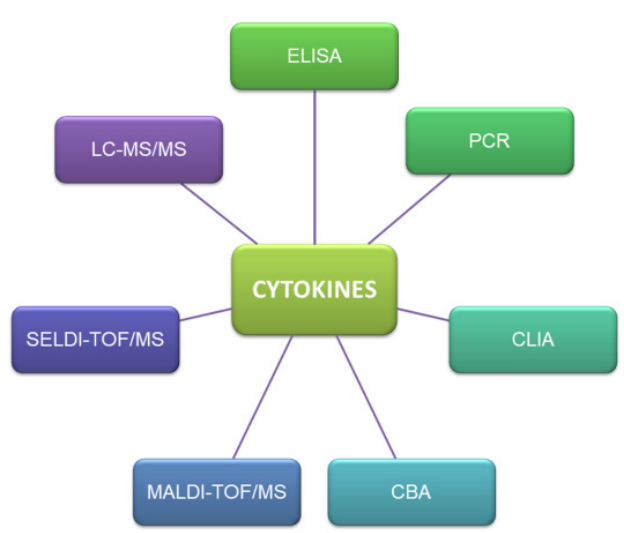
Figure 10. The popular methods of cytokines analysis.